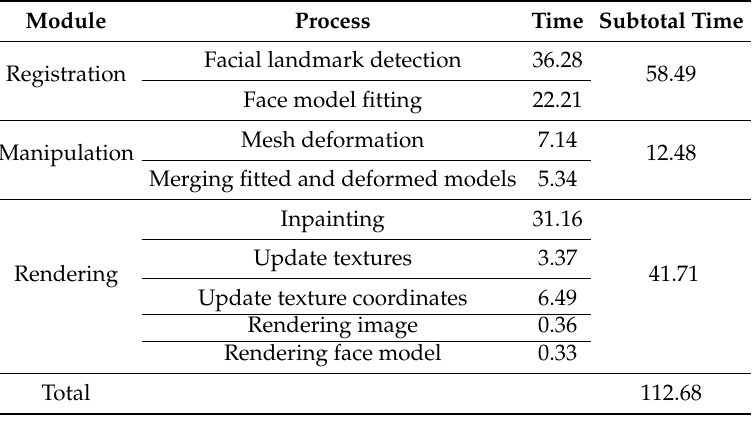
Table 2. Total processing time